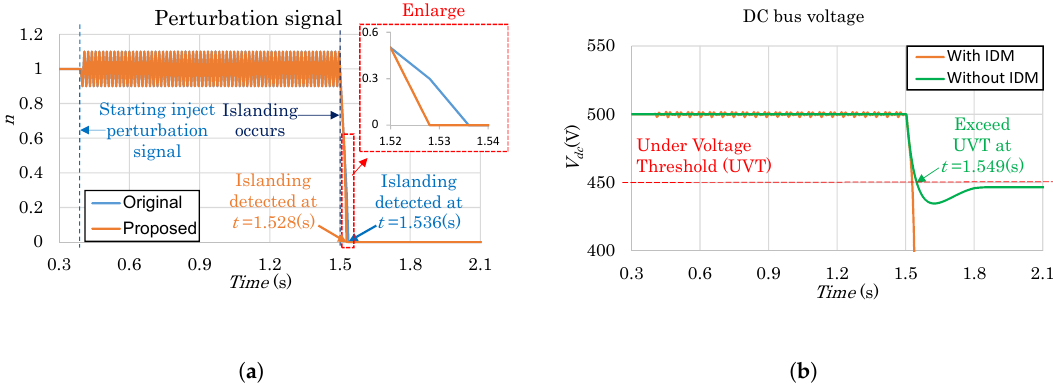
Figure 14. Result in case of multi-PV operation, 200 kW PV, another islanding condition (case 2): ( a ) Perturbation signal and ( b ) DC bus voltage (with and without IDM).